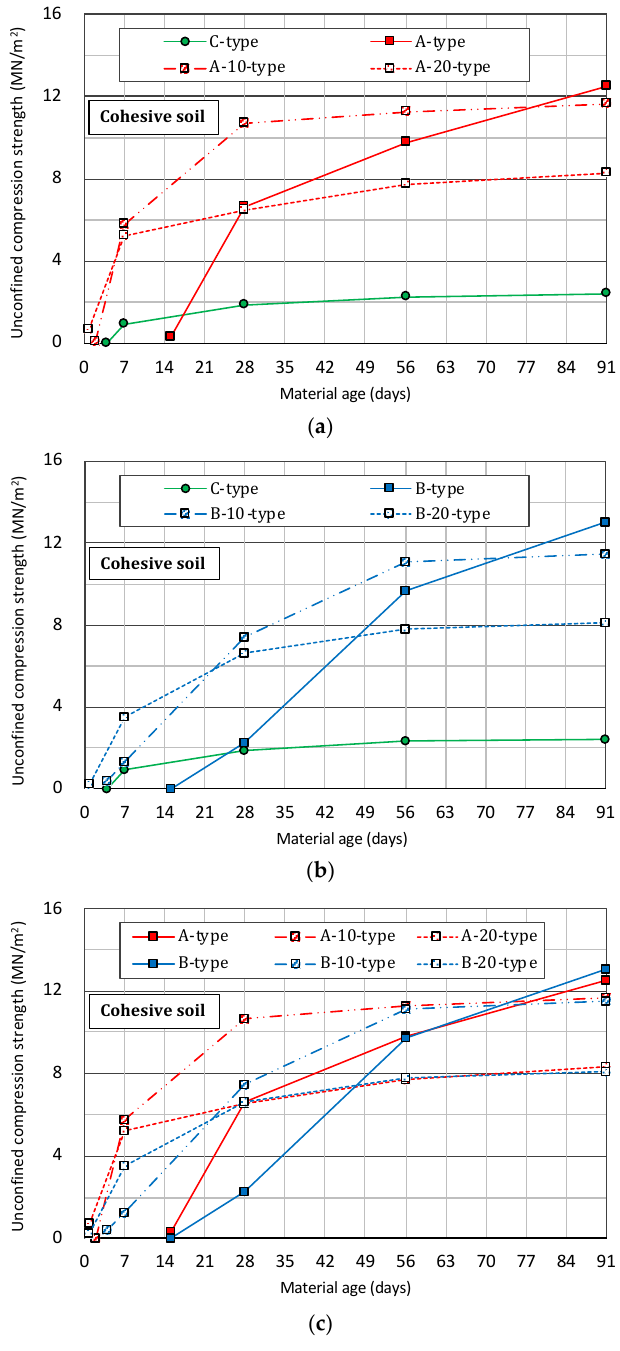
Figure 5. Changes over time in the unconfined compression strength of the specimen prepared by mixing cohesive soil and a slurry solution of various solidifying materials with the passage of the material age. ( a ) A-type and C-type. ( b ) B-type and C-type. ( c ) A-type and B-type. In the strength comparison of the A-type and the B-type, shown in Figure 5c, the A- type shows some superiority in terms of early solidification. However, under the same mixing conditions, each improved soil body develops almost the same level of strength after the material age of 56 days. From this, it can be confirmed that the B-type can be applied in the same manner as the A-type based on the fact that there is a slight difference in strength development due to early solidification.